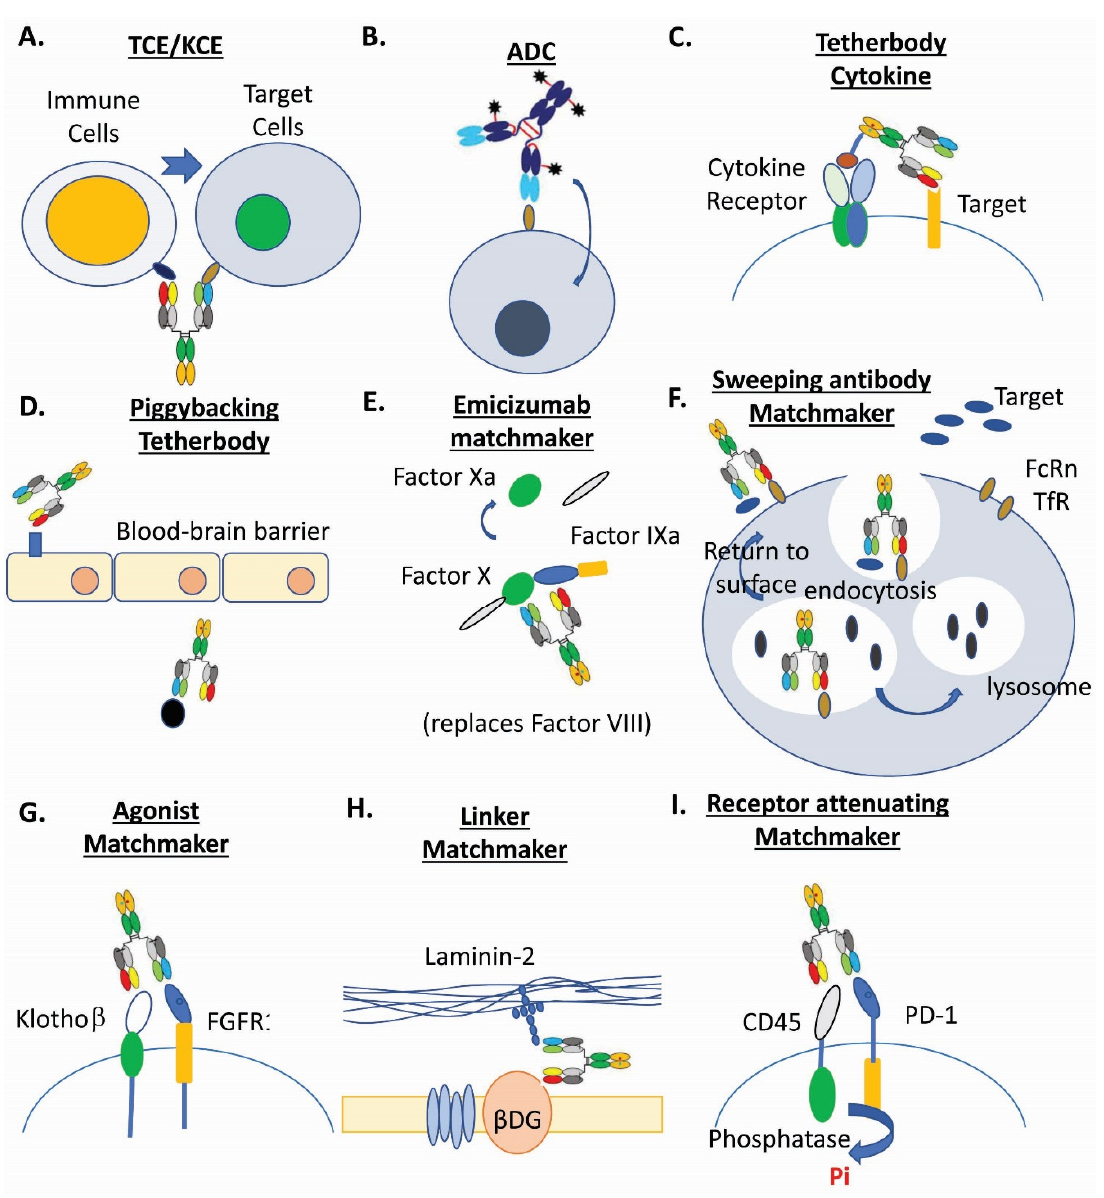
Figure 1. Examples of multispecific biotherapeutics drugs. ( A ). T-cell and NK-cell engagers (TCE/KCE) [4,5,11]. ( B ). Antibody-drug conjugates (ADC) [3,6,15,17,18,31]. ( C ). Tetherbody cytokine [95]. ( D ). Piggybacking tetherbody [96–98]. ( E ). Emicizumab matchmaker [99,100]. ( F ). Sweeping antibody matchmaker [3,101]. ( G ). Agonist matchmaker [102,103]. ( H ). Linker matchmaker [104]. ( I ). Receptor attenuating matchmaker